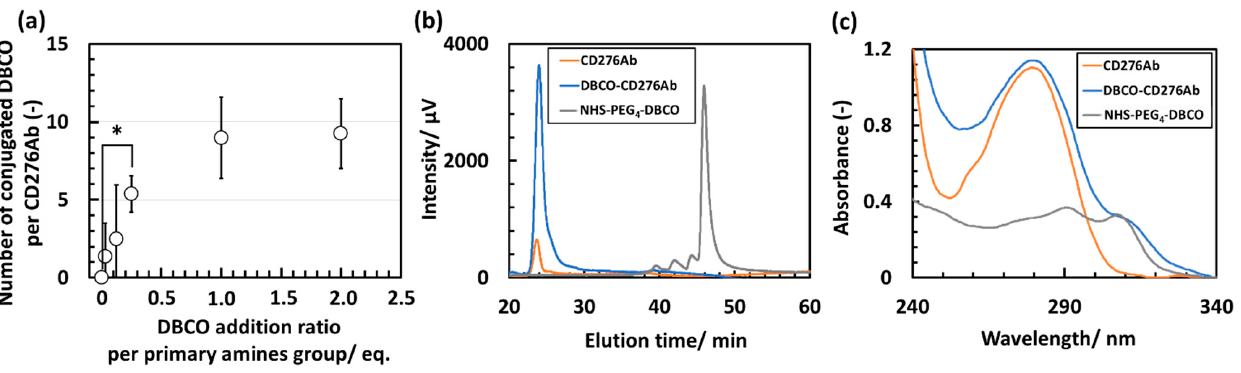
Figure 2. Characterization of DBCO-CD276Ab through fluorescamine assay, SEC, and UV absorption. ( a ) Number of DBCO conjugated to CD276Ab at various NHS-PEG 4 -DBCO addition concentrations, calculated using fluorescamine assay. N = 5. Statistical analysis was conducted via t -test, and the significant difference detected was represented by * p < 0.05. Data are shown in average ± standard error. ( b ) Chromatogram traces of CD276Ab (Orange), DBCO-CD276Ab (Blue), and NHS-PEG 4 -DBCO (Gray) measured by SEC (Detector: UV at 312 nm, flow rate: 0.5 mL/min, eluent: 10 mM PB (pH 7.4), 500 mM NaCl). ( c ) UV absorbance spectrum of CD276Ab (orange), DBCO-CD276Ab (blue), and NHS-PEG 4 -DBCO (gray).